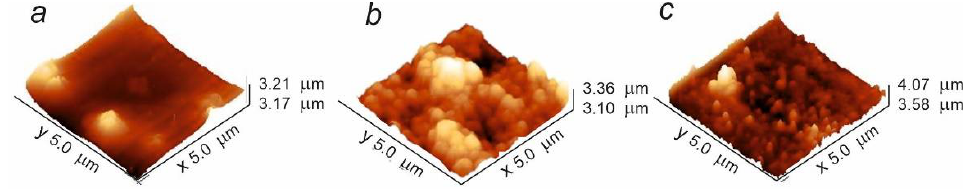
Figure 7. AFM topographical maps of uncoated TiNi substrate ( a ), coatings synthesized in argon ( b ) and nitrogen ( c ).